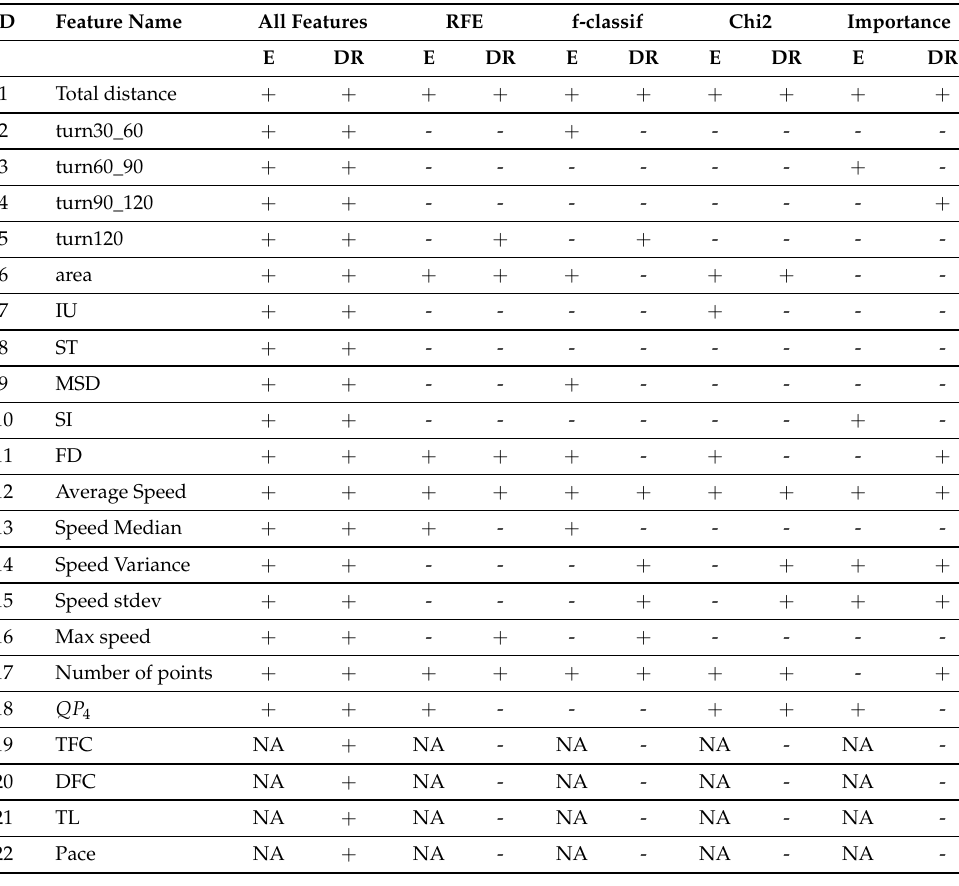
Table A5. Potential subsets of features obtained by different feature selection